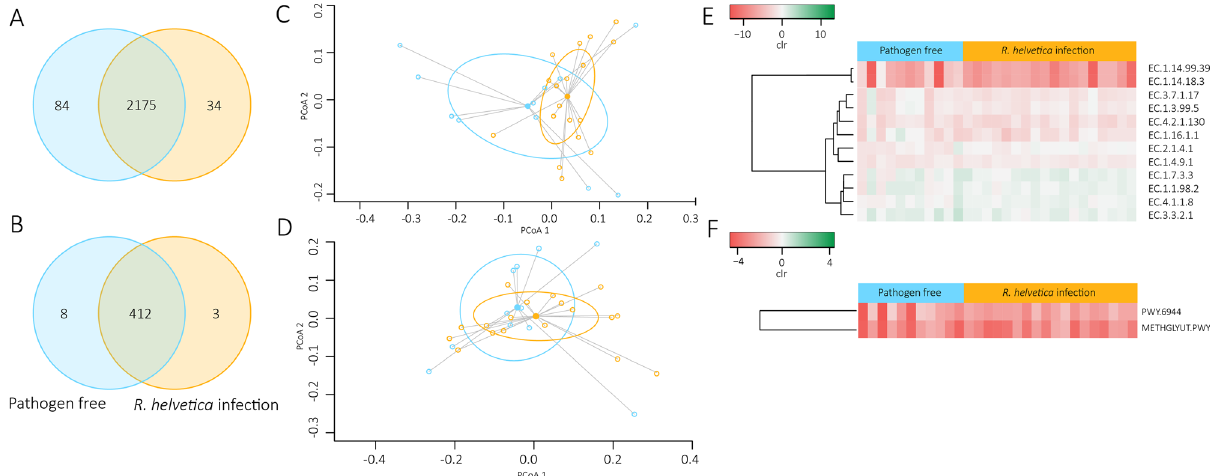
Figure 5. Comparison of unique and shared enzymes and pathways in the different groups and significant changes in relative abundance. A Venn diagram displaying the comparison of ( A ) enzymes and ( B ) pathways composition between the R. helvetica- positive and pathogen-free I. ricinus ticks. The blue and red circles represent the enzymes or pathways in pathogen-free or R. helvetica- positive samples, respectively. Numerals represent the number of enzymes or pathways found in each dataset and those shared by the two groups. ( C ) Comparison of beta-diversity with Bray Curtis dissimilarity index for enzymes of R. helvetica and pathogen-free samples. Small circles represent samples, and ellipses represent centroid position for each group (bray–curtis index, PERMANOVA, p > 0.05). Beta dispersion of the two sets of samples. ANOVA test was performed and showed that beta dispersion of the two sets of samples is significantly different ( p = 0.008). ( D ) Comparison of beta-diversity with Bray Curtis dissimilarity index for pathways of R. helvetica and pathogen-free samples (bray– curtis index, PERMANOVA, p > 0.05). Beta dispersion of the two sets of samples. ANOVA test was performed and showed that beta dispersion of the two sets of samples is not significantly different (ANOVA, p = 0.08). ( E